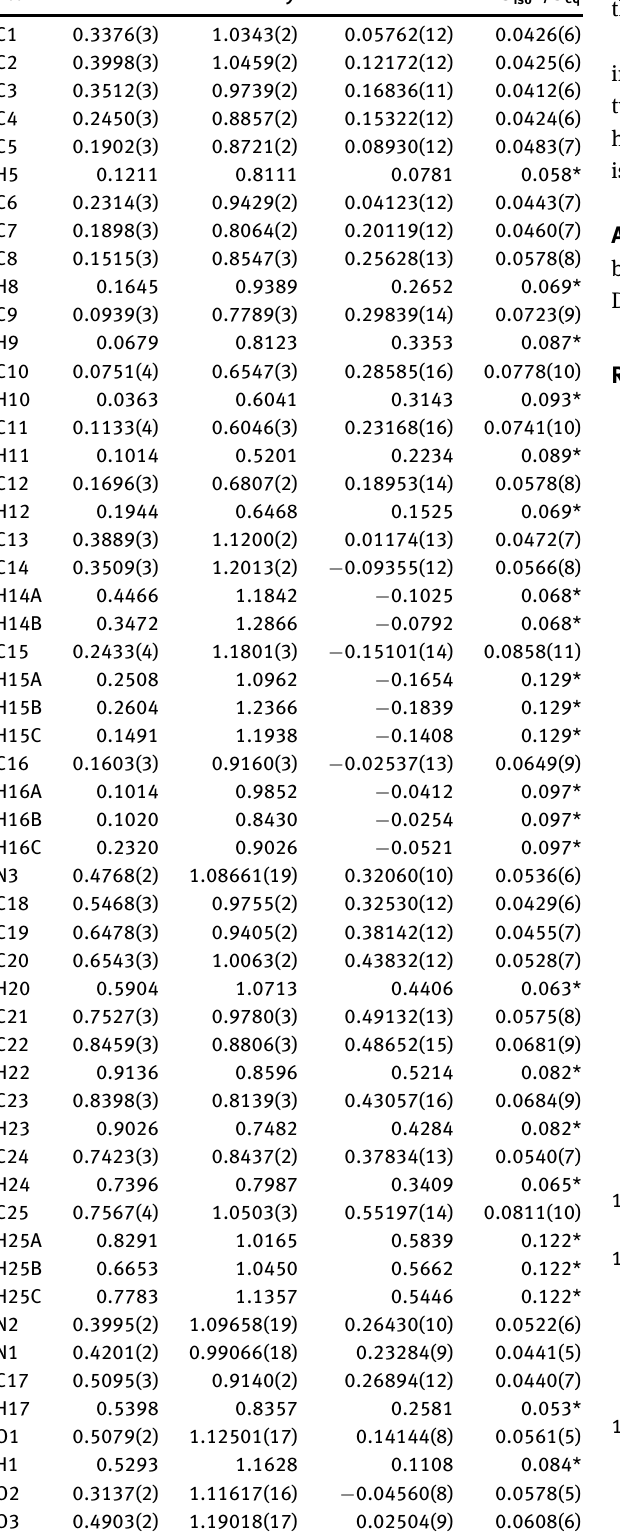
Table 2: Fractional atomic coordinates and isotropic or equivalent isotropic displacement parameters (Å 2